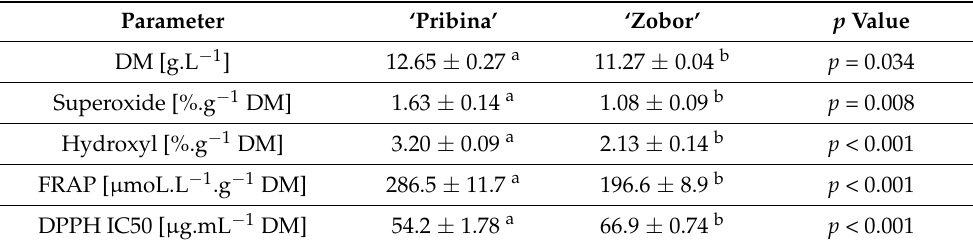
Data represent the mean ± s.d. (standard deviation); a, b values showed differences between extracts; con- centration of reference were: GAE 1 mmol.L − 1 ; Superoxide SA 1 mmol.L − 1 and in FRAP 0.1 mmol.L − 1 GAE; GAE = Gallic acid equivalents; SA = sodium salicylate; DM = Dry